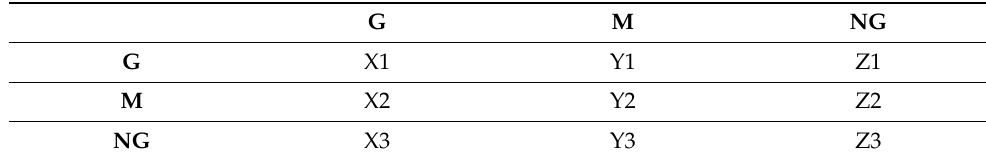
Table 3. Interaction among different types of